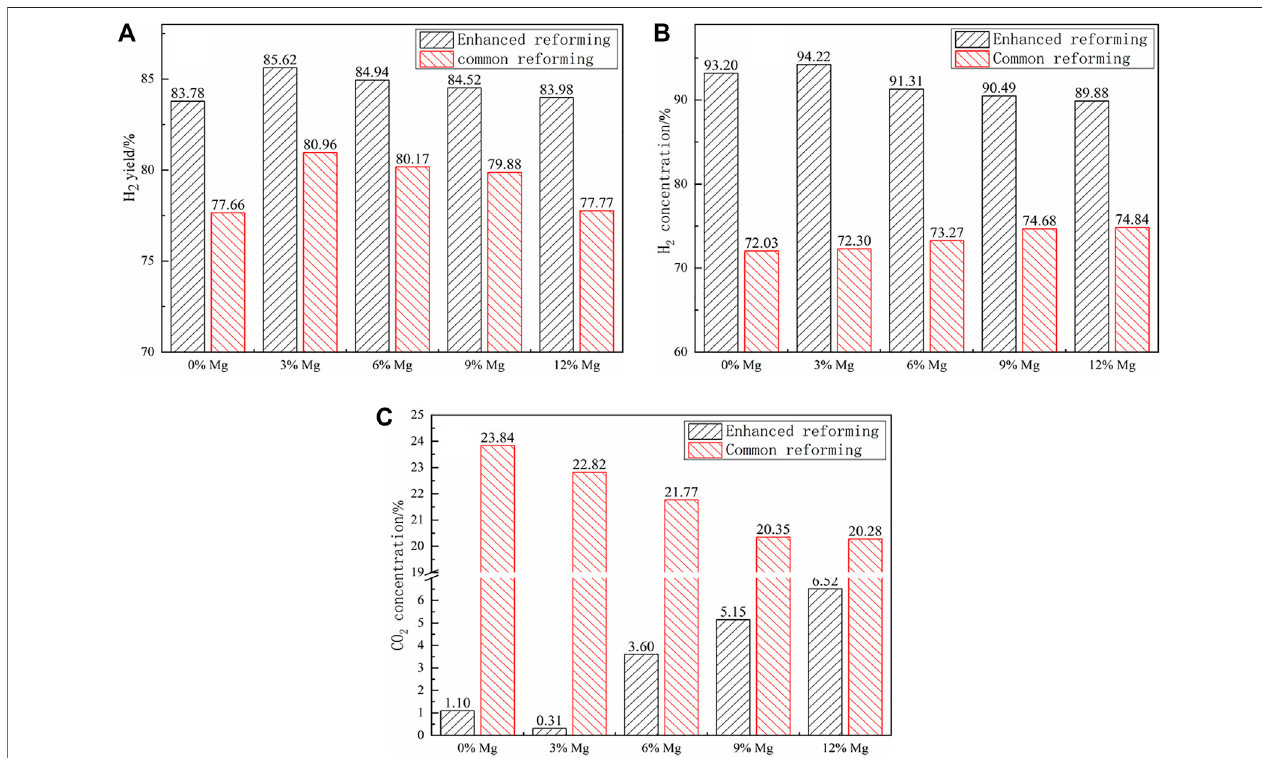
FIGURE 8 | Effect of the Mg-modi fi ed catalyst: (A) H 2 yield, (B) H 2 concentration, and (C) CO 2 concentration.